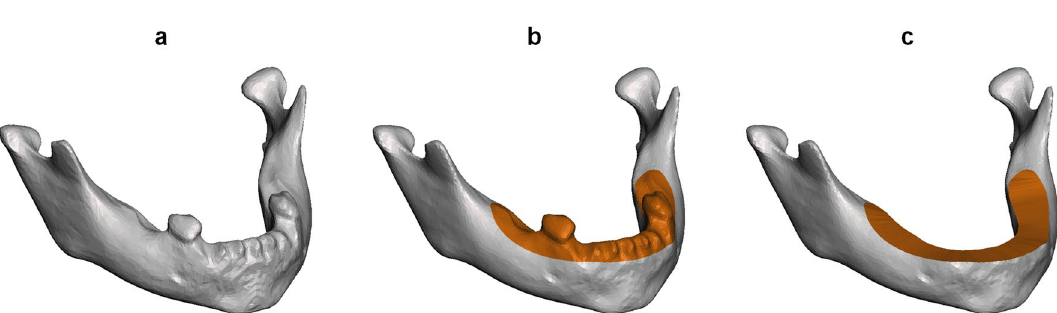
Figure 2. STL post-processing. Original reconstruction ( a ), after remeshing and manual selection (orange region) of the dental region ( b ), and after leveling ( c